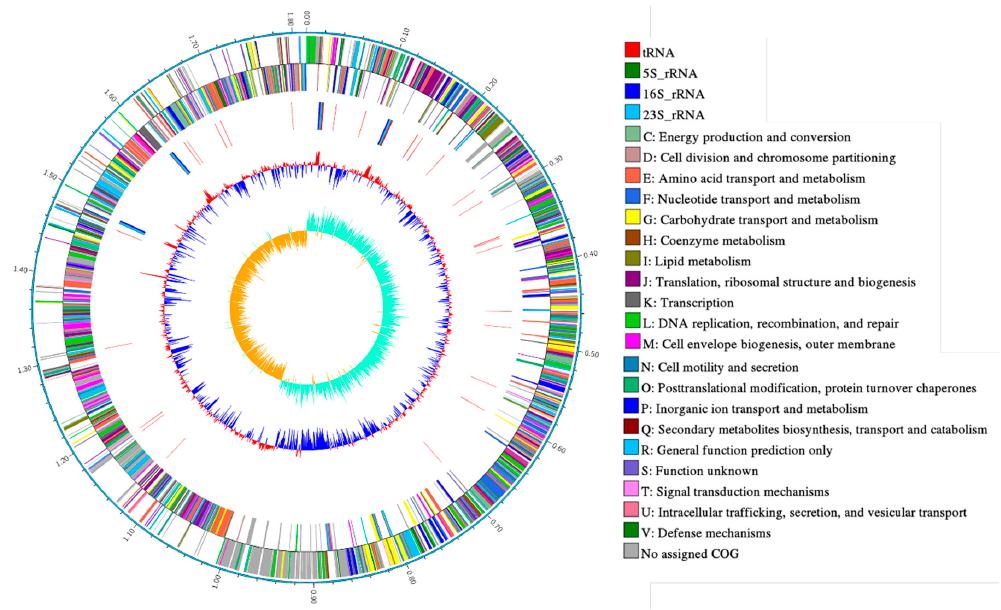
Figure 1. Circular genome map of Leuconostoc mesenteroides DRP105. Table 2. Statistics table of the gene prediction information.